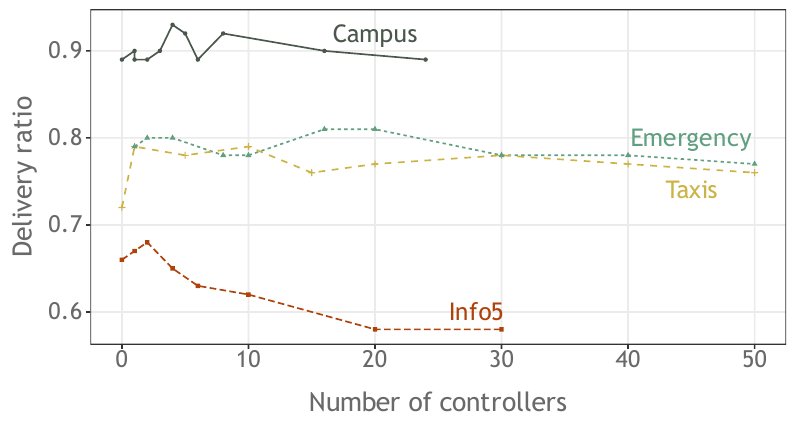
Figure 12. Delivery ratio by number of